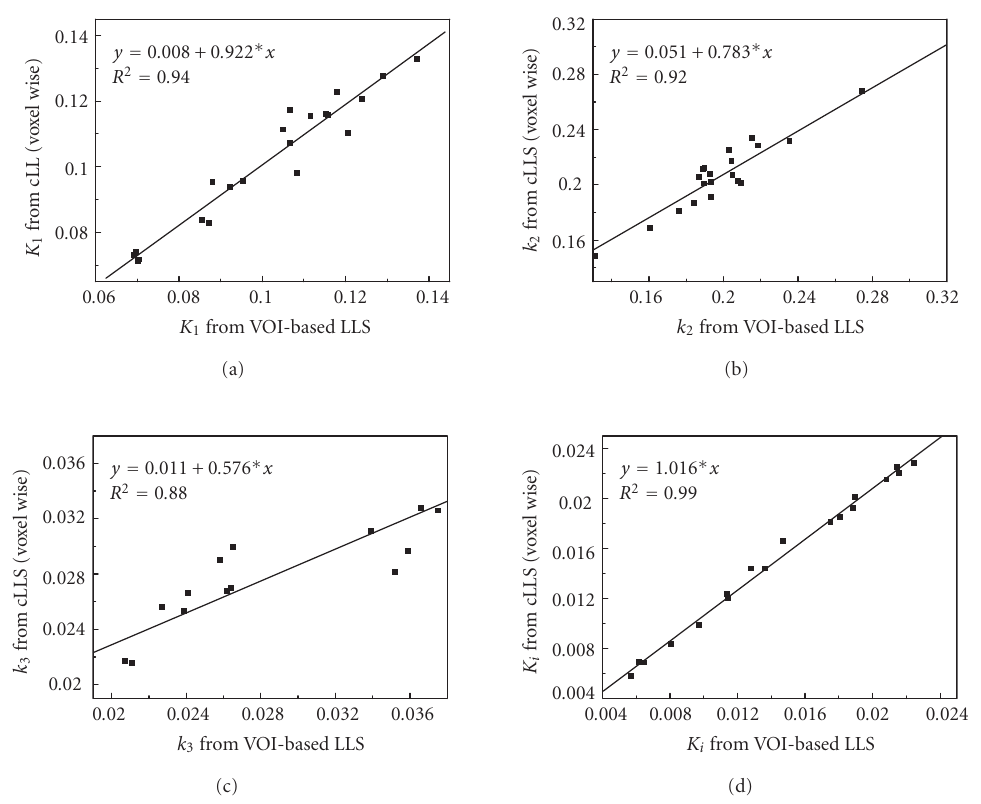
Figure 4: The correlation of voxel-based average parameters of VOIs in parametric image space with the parameters derived from VOI kinetic analysis with conventional LLS